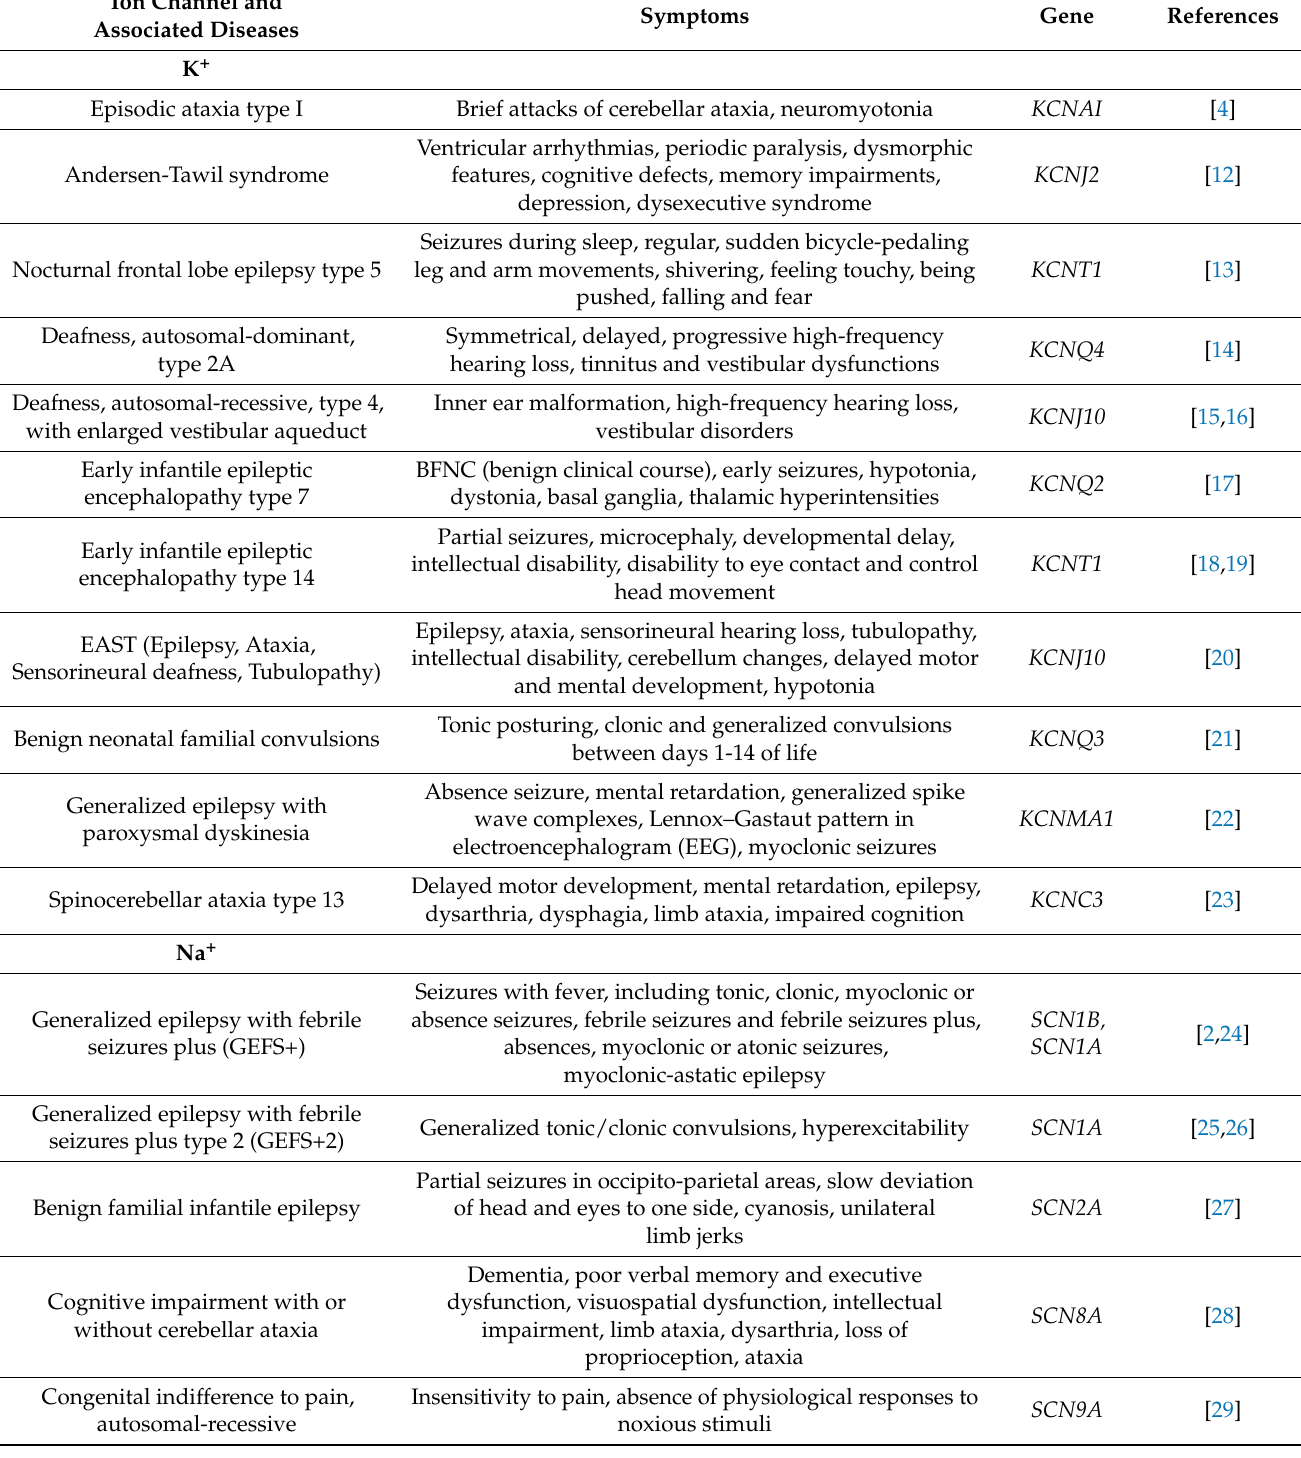
Table 1. Selected CNS channelopathies in